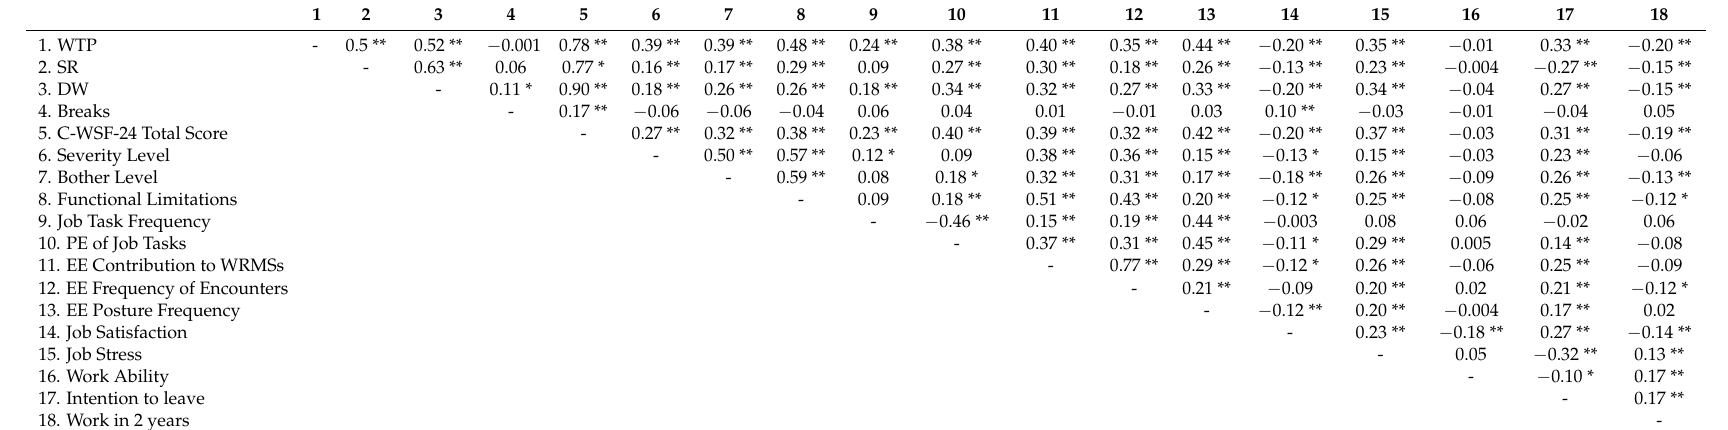
Table 4. Correlations between C-WSF-24 and WRMSs’ contributing factors by non-parametric Spearman’s rho.